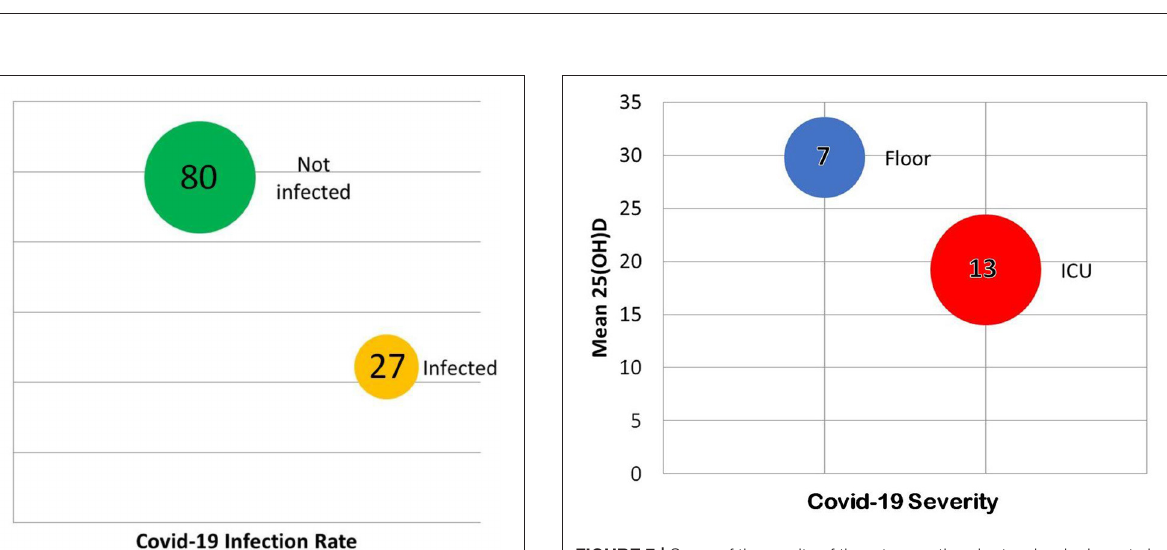
FIGURE 5 | Some of the results of the retrospective chart review by Alipio et al. (3). Of the 212 hospitalized COVID-19 patients, 96% of those with mild COVID-19 had normal vitamin D levels (above 30ng/ml). In contrast, over 50% of the patients with severe or critical COVID-19 were vitamin D deficient (level 20ng/ml or lower).